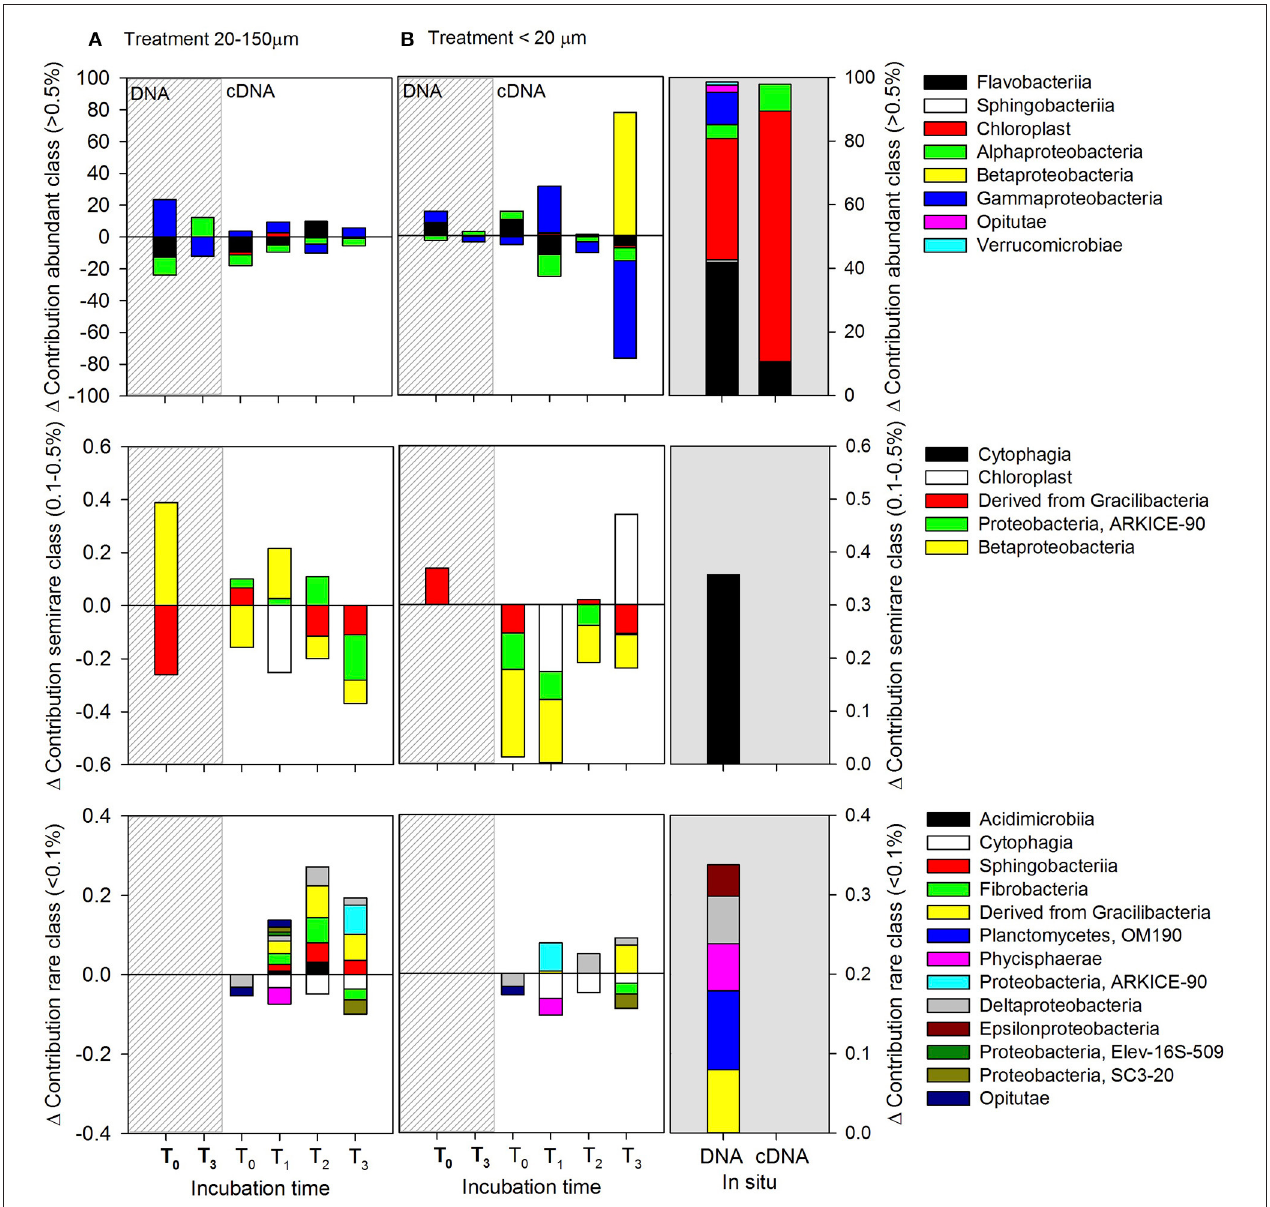
FIGURE 10 | Abundant ( > 0.5%), semi-rare (0.1–0.5%), and rare ( < 0.1%) classes, classified according to their initial in situ contribution throughout the whole incubation period during spring (December). The relative abundances of each class in the control were subtracted from the treatments. Positive values indicate a higher presence in treatments than in the control and vice versa for negative values. (A) Treatment inoculated with dissolved compounds excreted by copepods fed with 20–150- µ m size-fraction diet, and (B) treatment inoculated with dissolved compounds excreted by copepods fed with the < 20- µ m size-fraction diet. The dashed lines indicate the composition of the total bacterial community